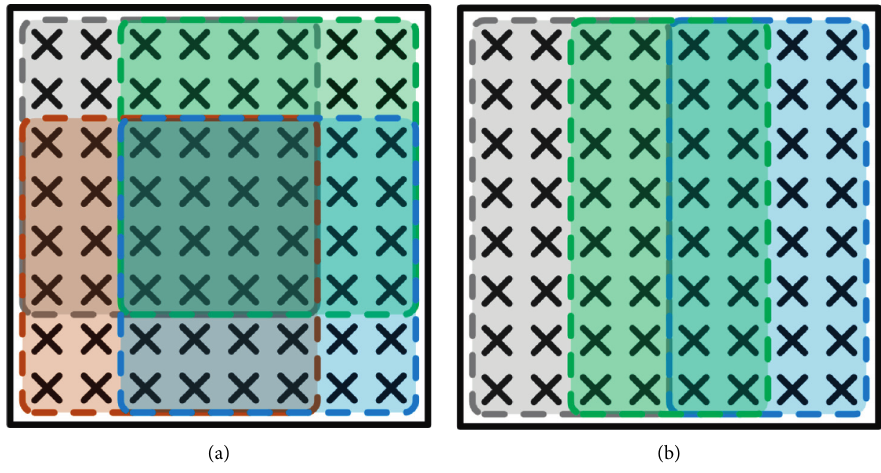
Figure 4: Illustration of 2D-OPC subarray structures: (a) v � 6 and h � 6; (b) v � 8 and h � 4.